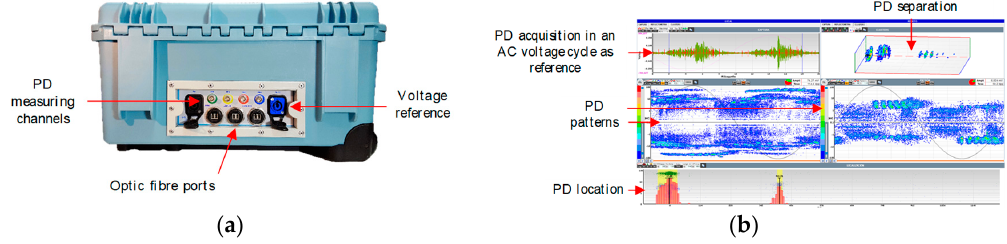
Figure 8. ( a ) Frontal view of the measuring device; ( b ) main interface window .